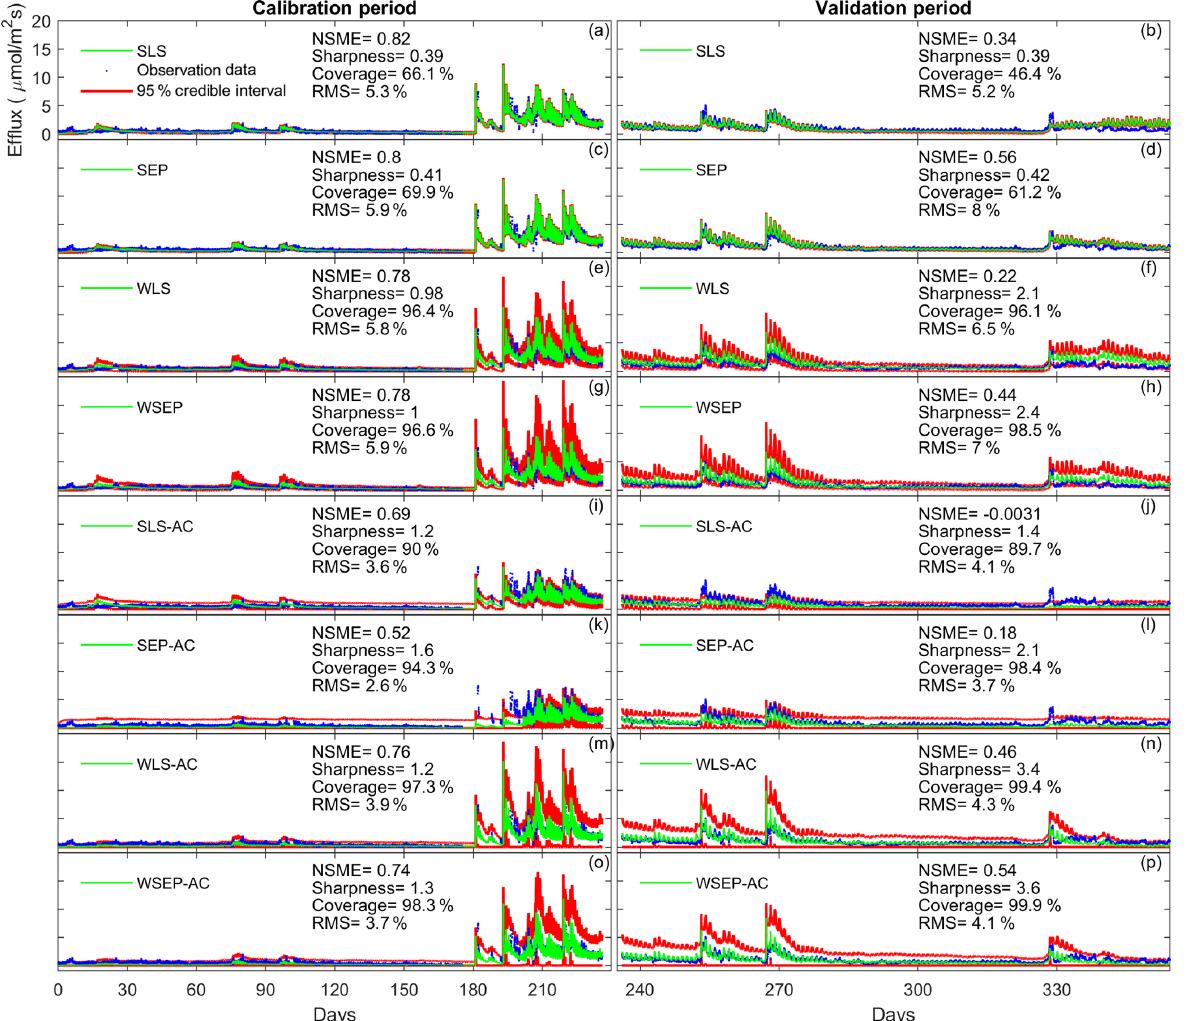
Figure 10. Observation data (blue dots), mean prediction (green line), and 95% credible intervals (red line) for 6C for the eight likelihood functions during the calibration period (a–h) and the validation period (i–p) . The prediction ensembles are generated to consider parametric uncertainty of not only the soil respiration models but also the data models. The model prediction accuracy, reliability, dispersion and overall predictive performance are measured by the Nash–Sutcliffe model efficiency (NSME), the predictive coverage metric (“Coverage”), the sharpness metric (“Sharpness”) and the relative model score (RMS), respectively. For clarity, the y axis markers and label are only displayed for the first subplot and are the same for all